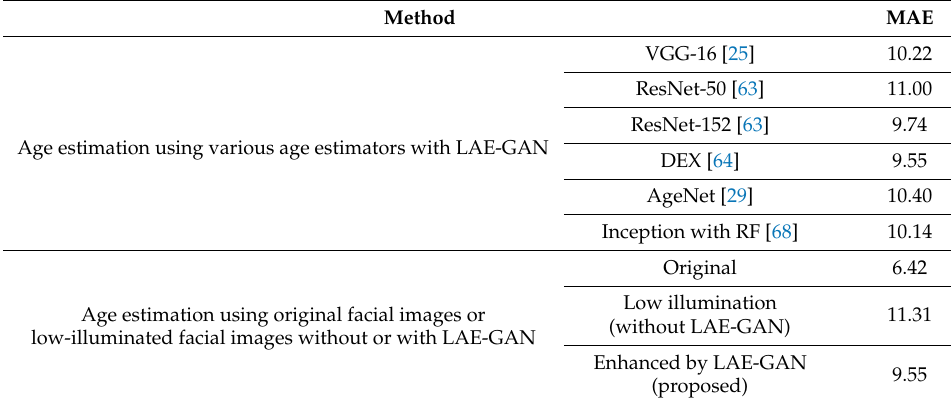
Table 8. Comparisons of age estimation accuracies by various methods on the FG-NET database (unit: